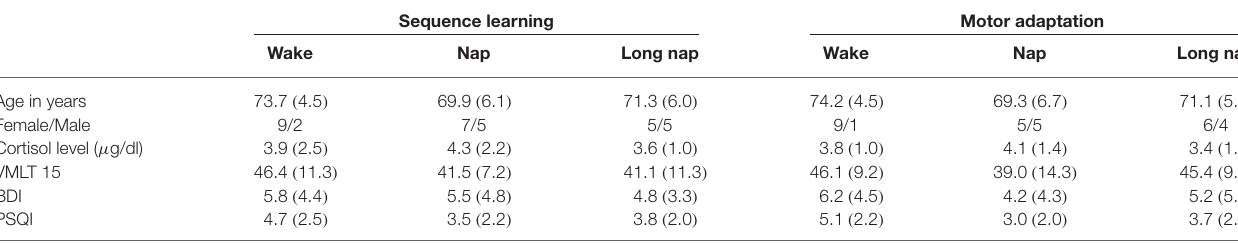
TABLE 1 | Baseline data displayed for sequence learning and motor adaptation. Sequence learning